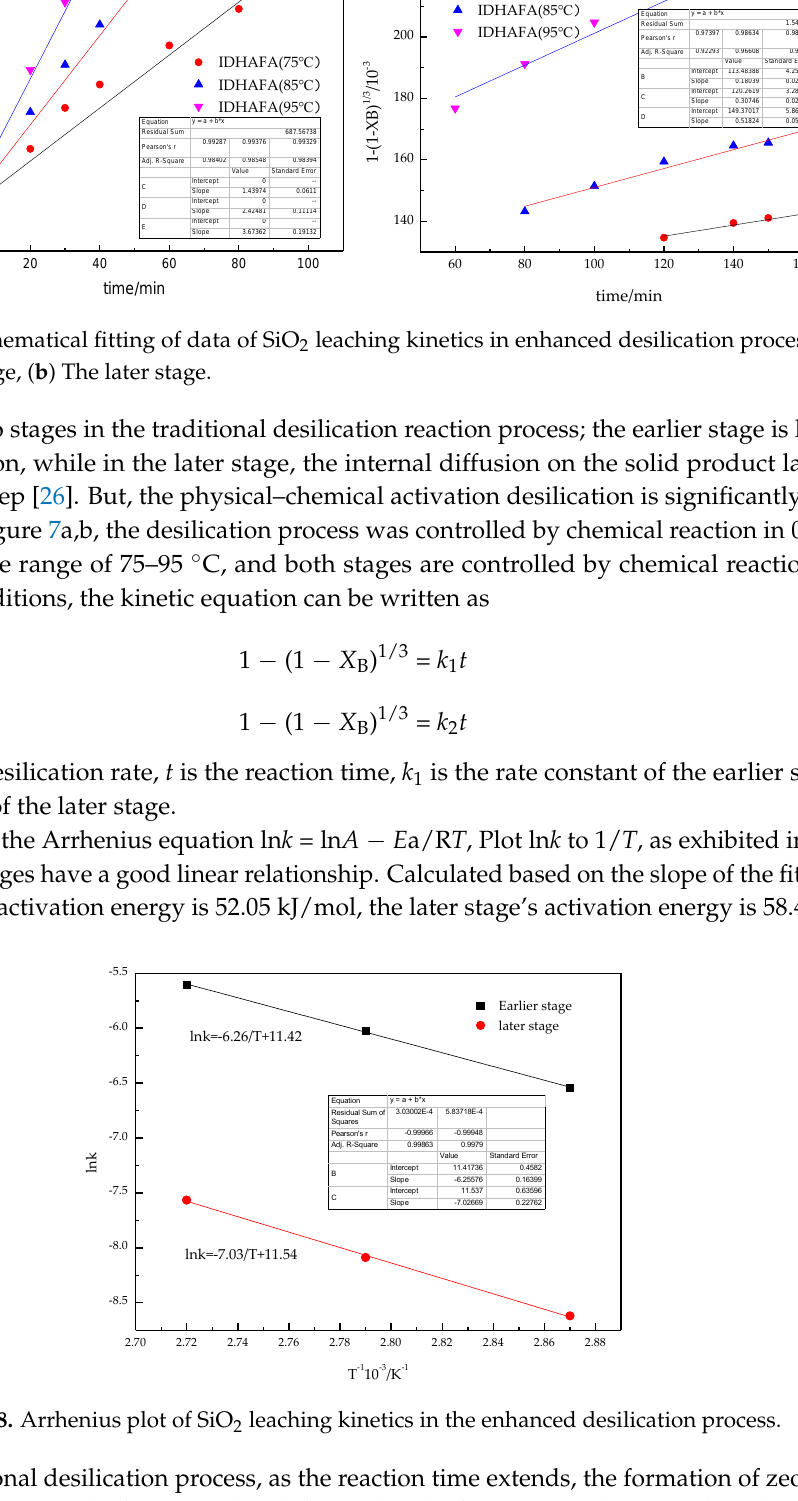
data. According to the reaction rate changing node in Figure 6, the SiO 2 leaching process is divided into two stages, and the fitting data are shown in Figure 7.